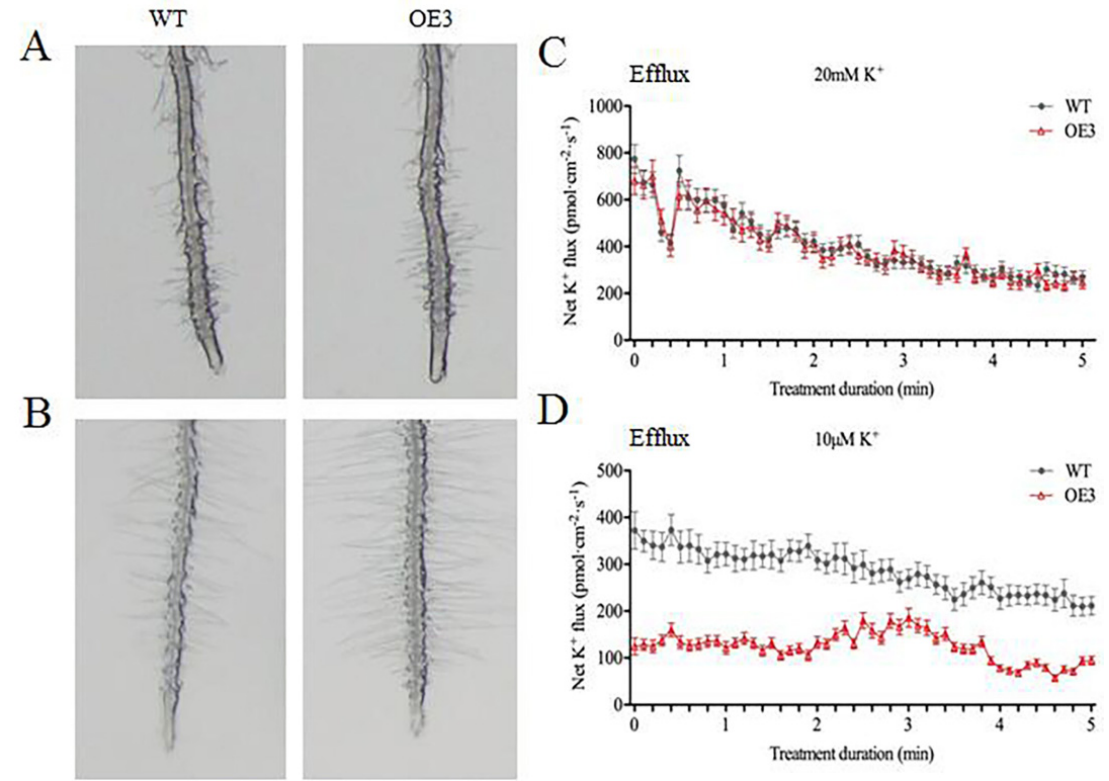
Figure 8. Root hair number and net K flux rates in roots of ApCPX1 transgenic tobacco lines. Note ( A ) morphology of root hairs under CK conditions; ( B ) morphology of root hairs under LK conditions; ( C ) net K flux rate analysis under CK conditions; ( D ) net K flux rate analysis under LK conditions. Positive value indicates K efflux.